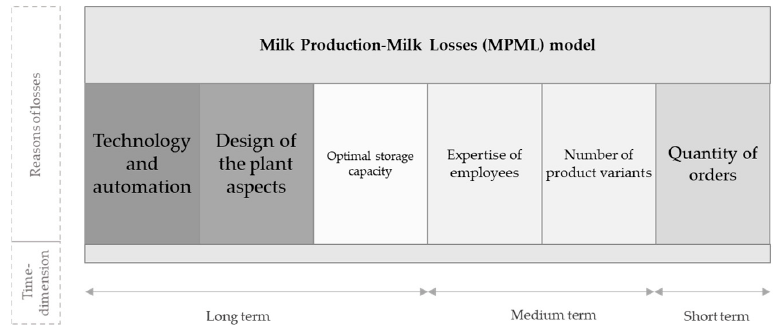
Figure 3. Milk Production-Milk Losses (MPML) model. Note: Causes occurring in most phases were marked with larger font size and a darker background. As the number of occurrences decreases, the font size decreases and the background colour becomes lighter.